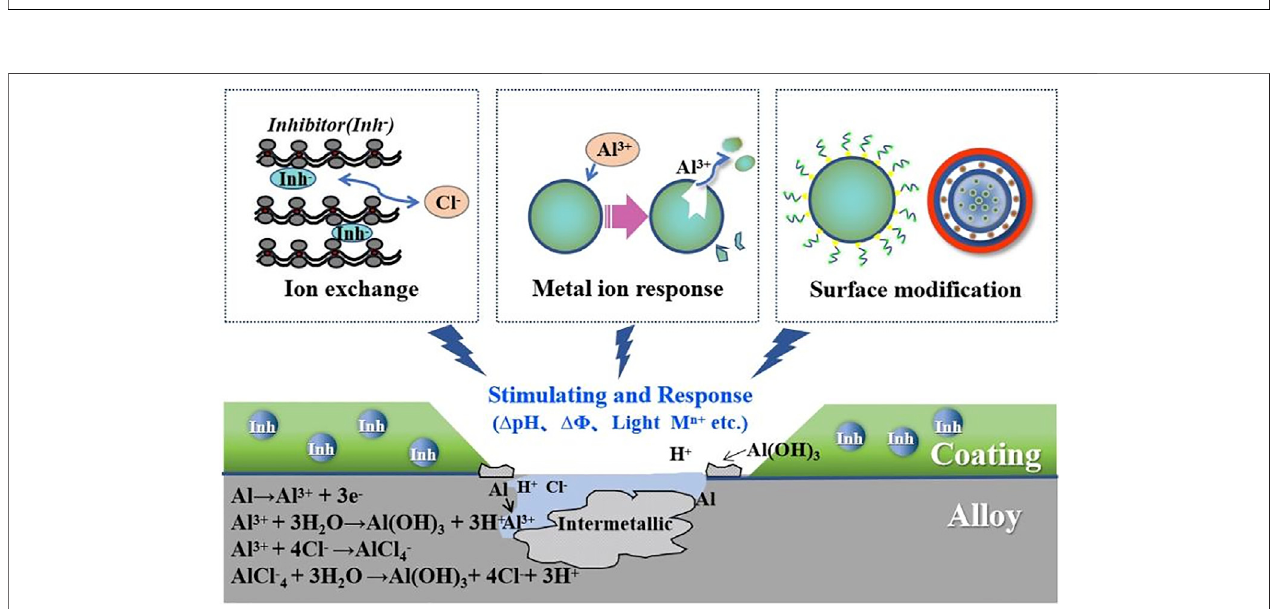
FIGURE 11 | Schematic diagram of the self-healing coating based on stimuli-responsive of corrosion inhibitors.